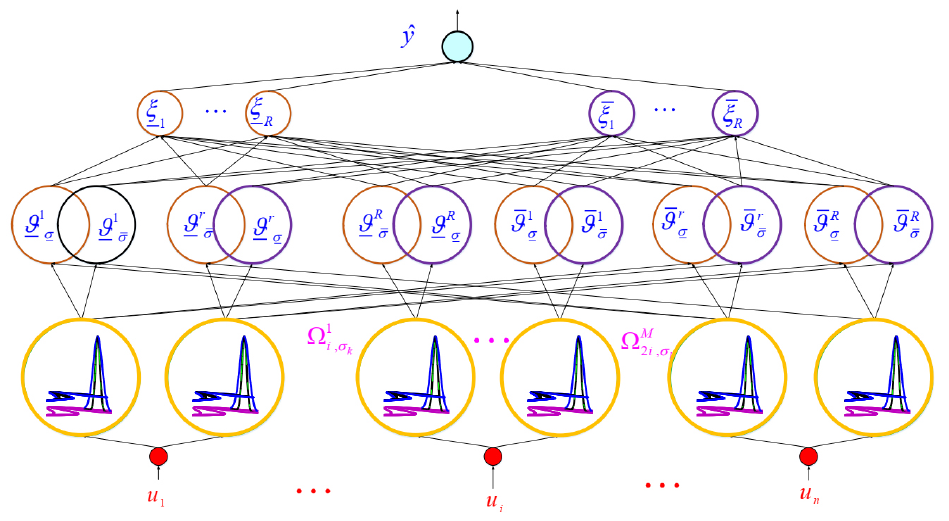
Figure 2. Structure of